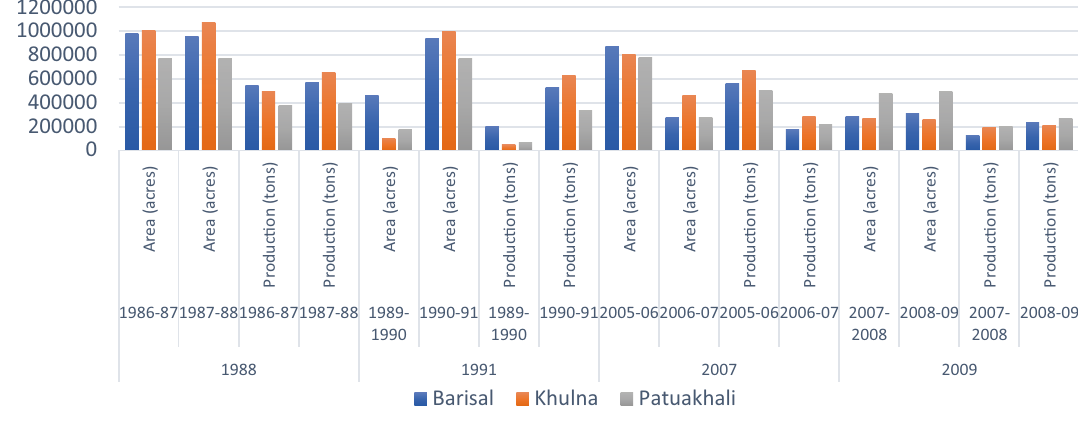
Fig. 6 Production and area variance of Aman Rice. Source: “45 years Agriculture Statistics of Major Crops”